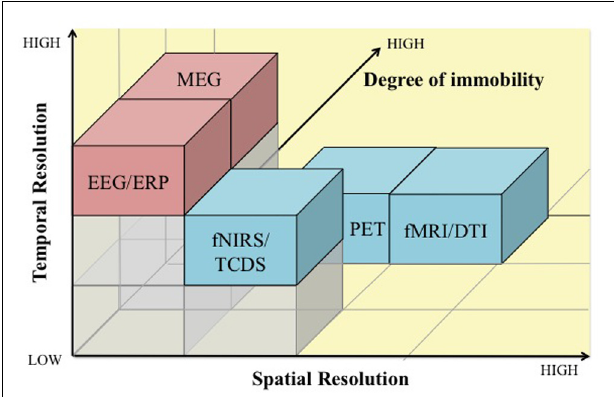
FIGURE 1 |A comparison of electromagnetic (pink) and hemodynamic (blue) neuroimaging techniques for use in neuroergonomics based on temporal resolution ( x -axis), spatial resolution ( y -axis), and degree of immobility ( z -axis). EEG, electroencephalography; ERP, event-related potentials; MEG, magnetoencephalography; fNIRS, functional near infrared spectroscopy;TCDS, transcranial Doppler sonography; fMRI, functional